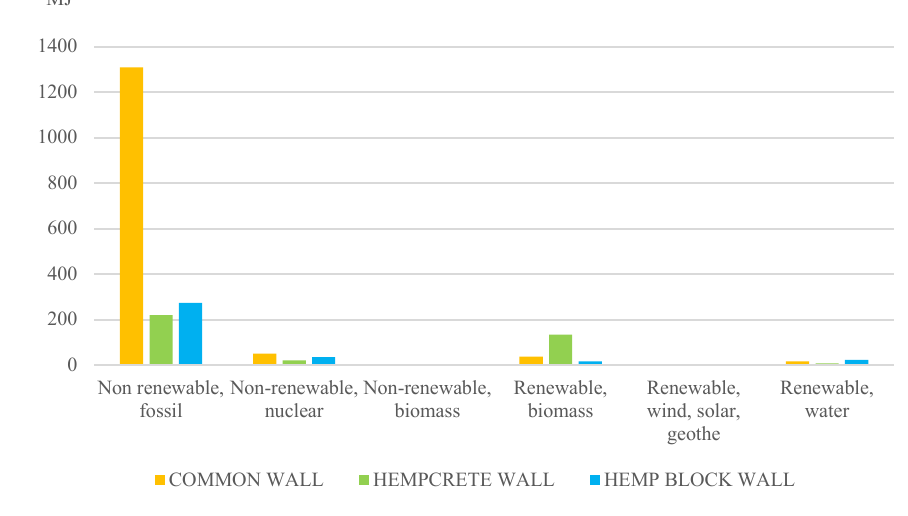
Fig. 4. Comparison among 1 m 2 of hempcrete wall, hemp blocks wall, common wall – Method CED (value in MJ).